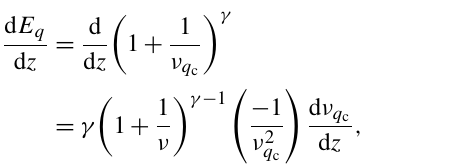
only the variability in cloud water in formulating E q .